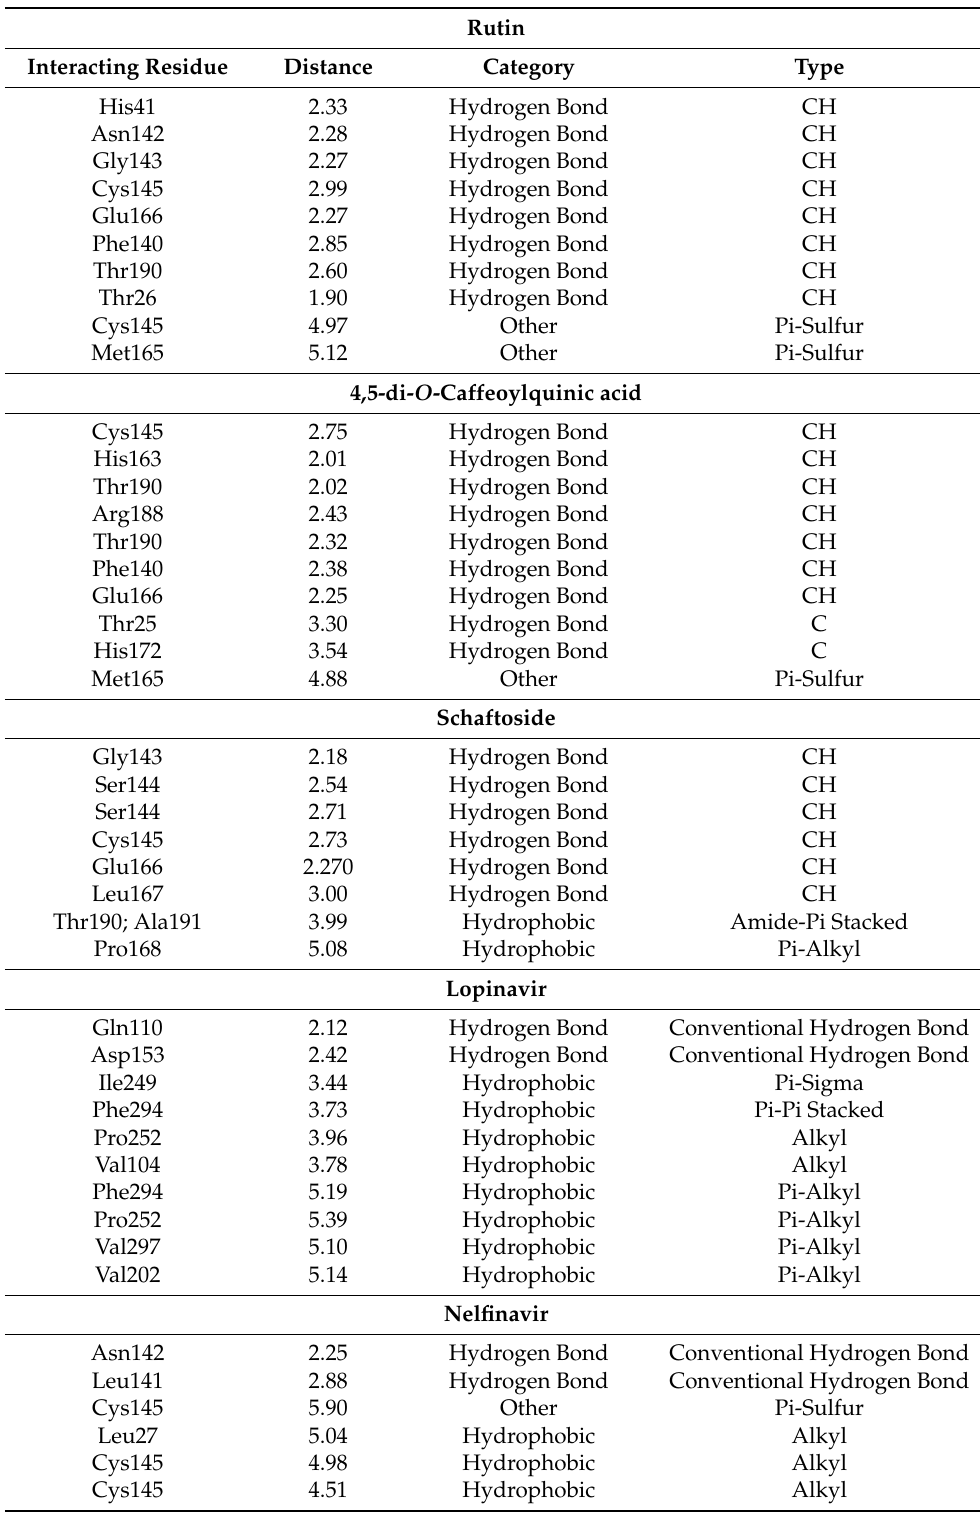
Table 2. Non-bonding interactions of the top three predicted high binding energy phytochemicals of Artemisia herba-alba to Mpro of SARS-CoV-2. (CH = conventional hydrogen bond; C = carbon hydrogen